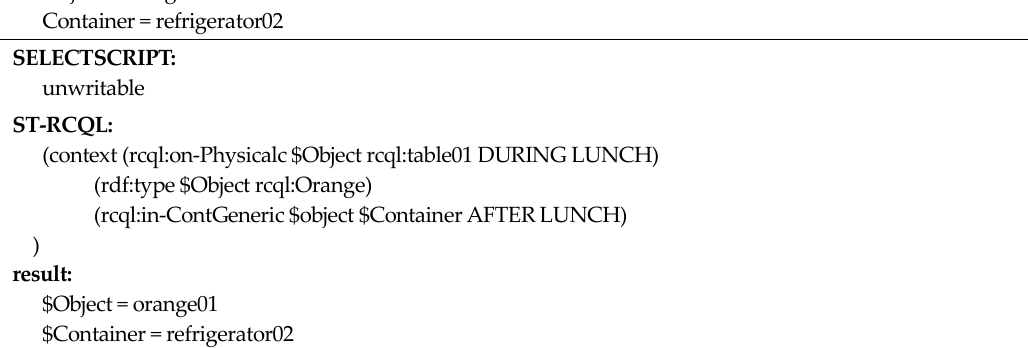
Figure 19. Experimental result of context query-processing by using reasoning types or spatio- temporal index ( a ) Reasoning time by reasoning types, ( b ) amount of inferred knowledge by reasoning types, ( c ) temporal query-processing time and ( d ) spatial query-processing time with respect to index.